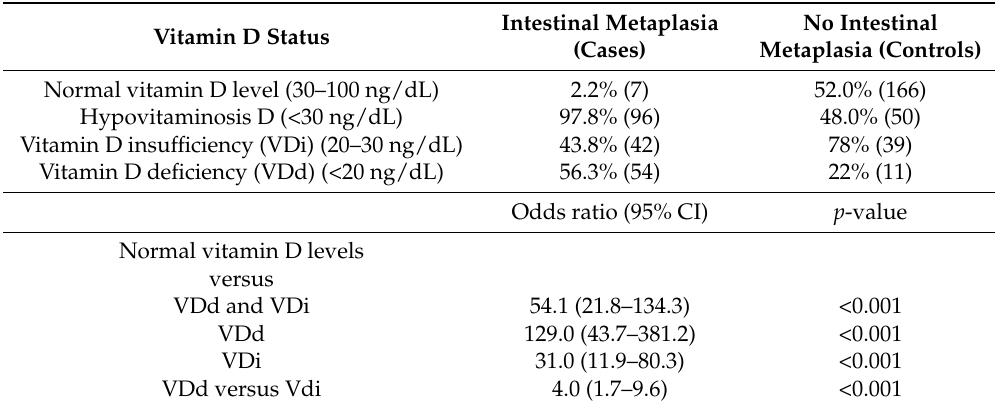
Table 2. Comparison of vitamin D states among patients with and without intestinal metaplasia. Vitamin D Status